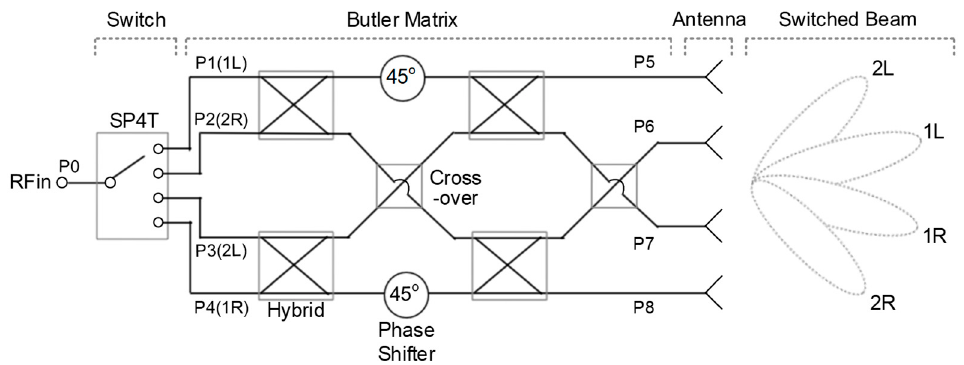
Figure 1. Switched-beam antenna system architecture.